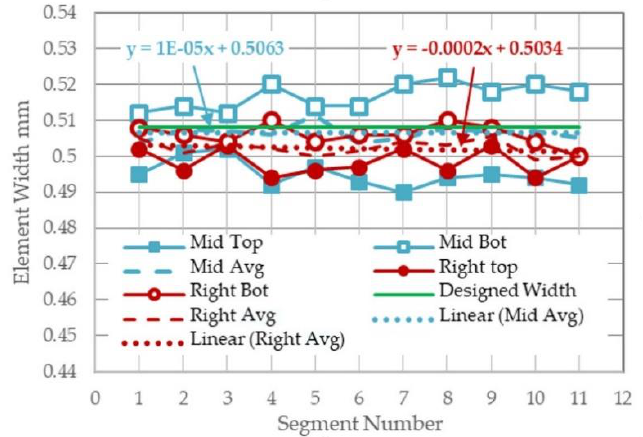
Figure 26. Element width measured at mid-span and one end of flexure cut with µ AWJ under stack cutting.